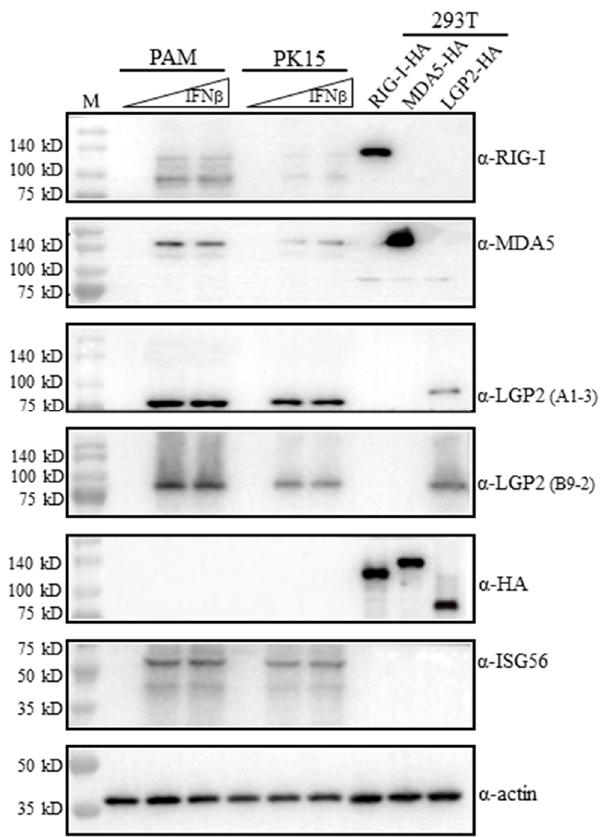
Figure 2. The reactivity of RLR mAbs with exogenous and endogenous porcine RLR proteins in Western blotting. 293T cells grown in 24-well plates (3 × 10 5 cells/well) were transfected with HA tagged pLGP2, pRIG-I, pMDA5 or pcDNA (0.5 µ g each) using Lipofectamine 2000 for 24 h. PAM cells and PK15 cells were plated on 24-well plates (2 × 10 5 cells/well) and stimulated with human IFN- β (500 IU/mL, 1000 IU/mL) for 8–12 h. The above cell lysates were analyzed by Western blotting using the pRIG-I, pMDA5 and pLGP2 ascite mAbs, ISG56 pAb, HA mAb and Actin mAb (1:1000 dilution each). The protein markers are labeled on the